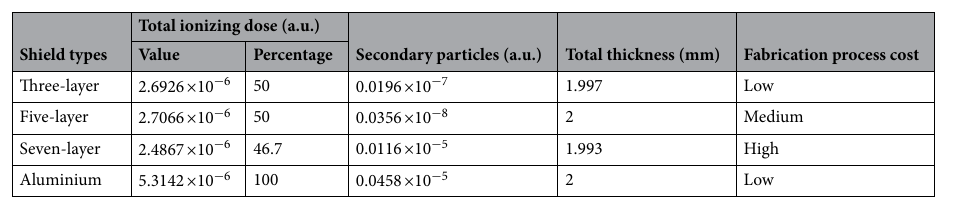
Table 5. Typical specifications of multi-layer radiation and Aluminum shields.